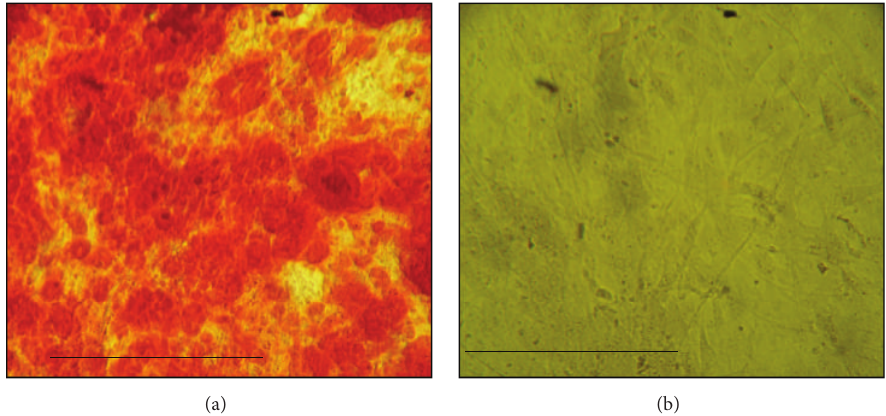
Figure 5: Osteogenic differentiated cells after 35 days in osteogenic induction medium: sample after thawing of cryopreserved cells, 250x rise. (a) ADMSC stained with Alizarin Red, demonstrating the presence of calcium in extracellular matrix. (b) Control without matrix demonstration, indicating the undifferentiated cells cultivated with standard culture medium. Scale (10 𝜇